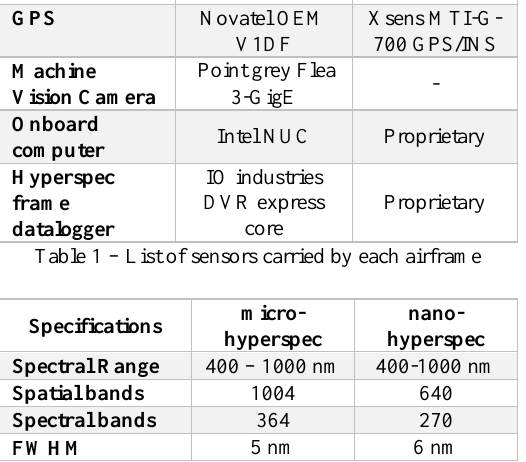
Table 2 – Hyperspectral camera specifications